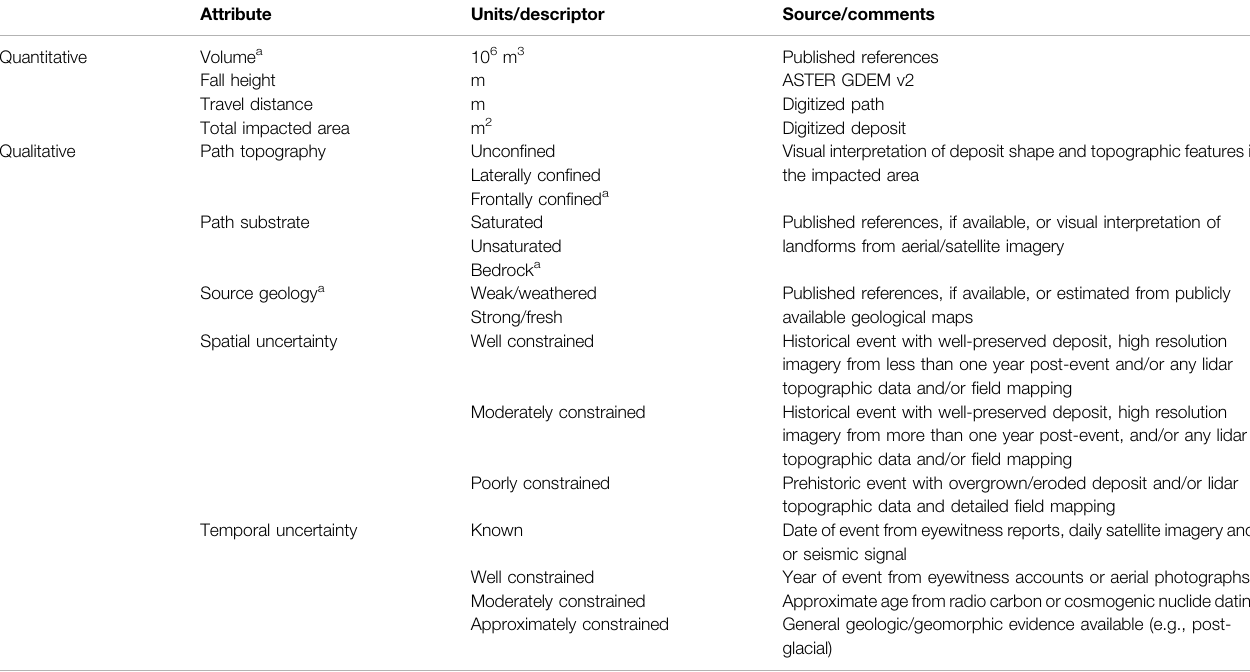
TABLE 1 | Attributes used to describe the Zone 1 and Zone 2 impact areas for events in the dataset.